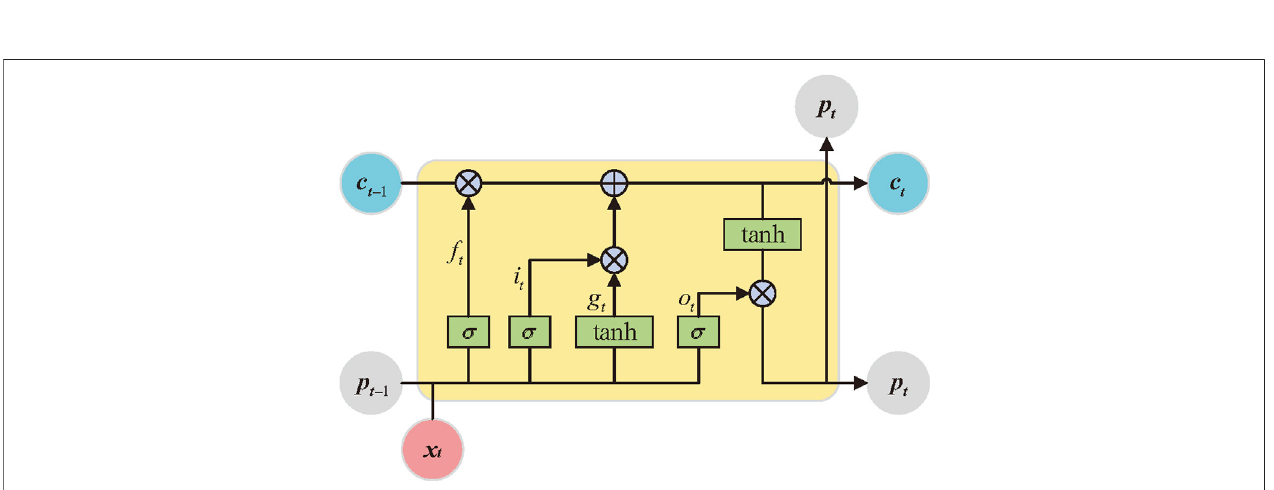
FIGURE 10 | Charging load decomposition effect of the traditional FHMM. (A) Charging states of EVs. (B) Charging power of each type of EV. (C) Total charging power of EVs decomposed based on the proposed method.